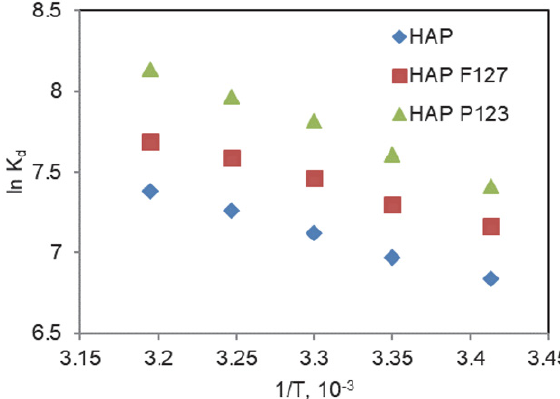
The positive values obtained for ΔHº and ΔSº indicate that the adsorption process is endothermic, and the affinity of the three sorbents for the aluminium ions is high. Negative Gibbs energy values show that the adsorption process is spontane-